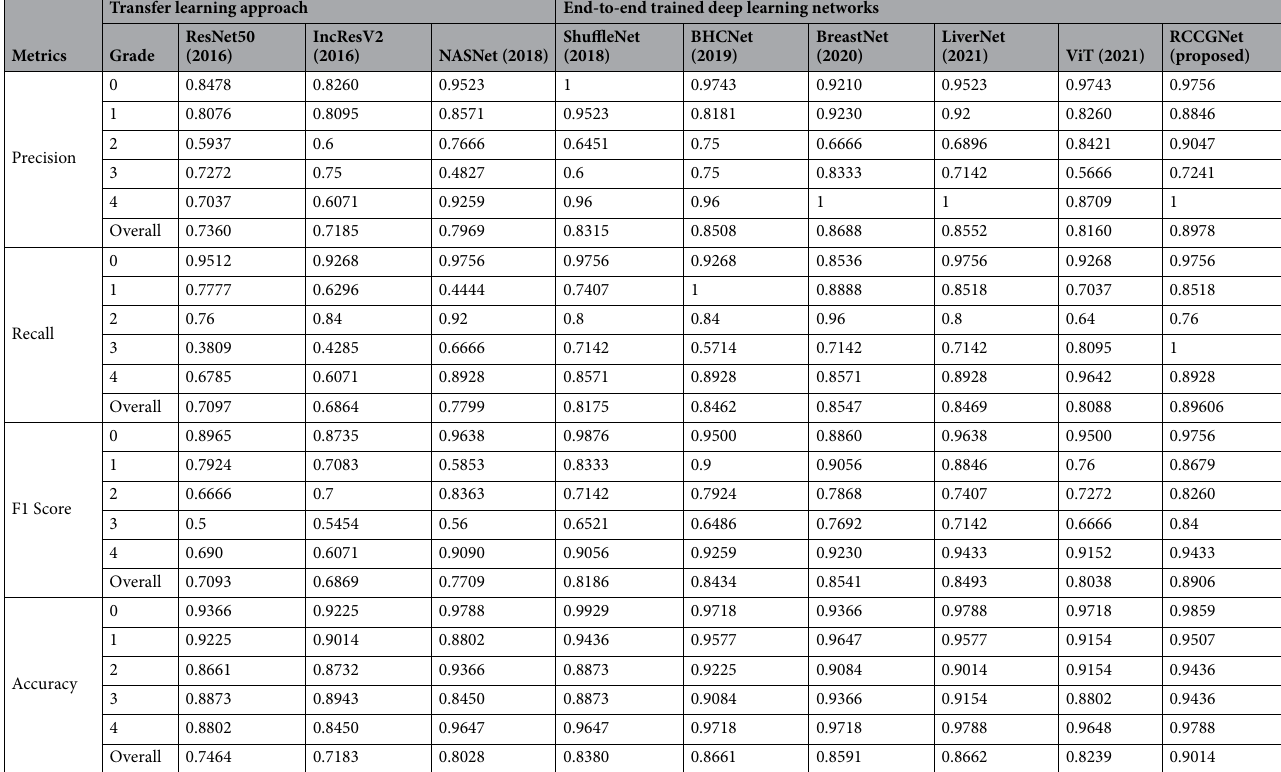
Table 4. Performance metrics comparison of proposed model with other competitive model (KMC kidney